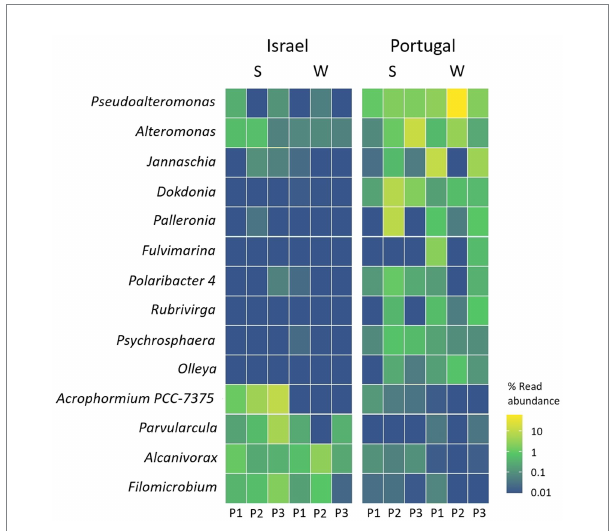
FIGURE 7 Genera in the plastic samples with significant higher relative mapped read abundance in one location over another (threshold–adjusted value of p (FDR) of <0.05). S = summer, W = winter.